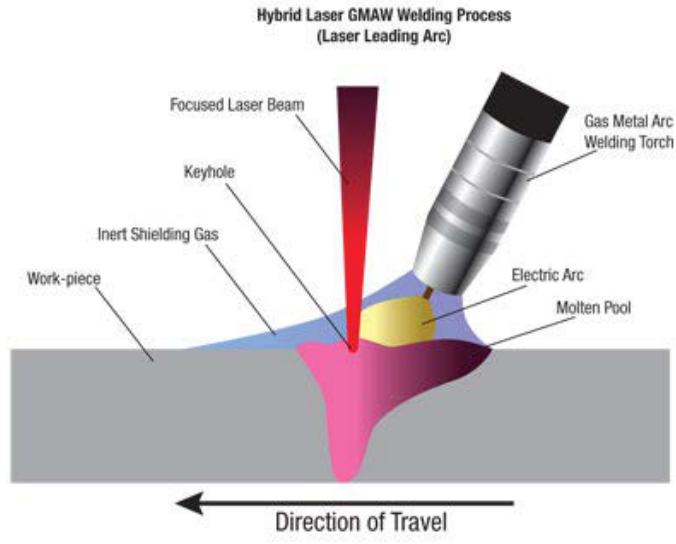
Figure 1. Schematic diagram of the hybrid welding process [26].